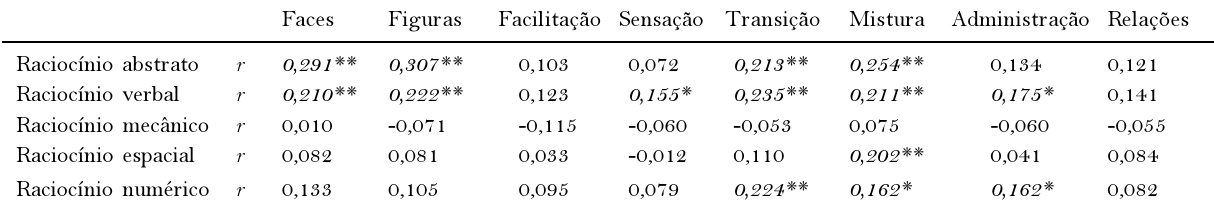
Facilitação Sensação Transição